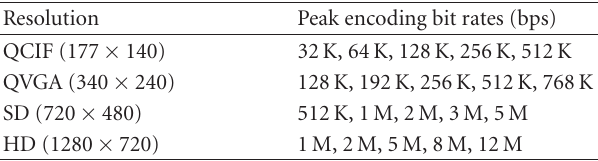
Table 1: Peak encoding bit rates